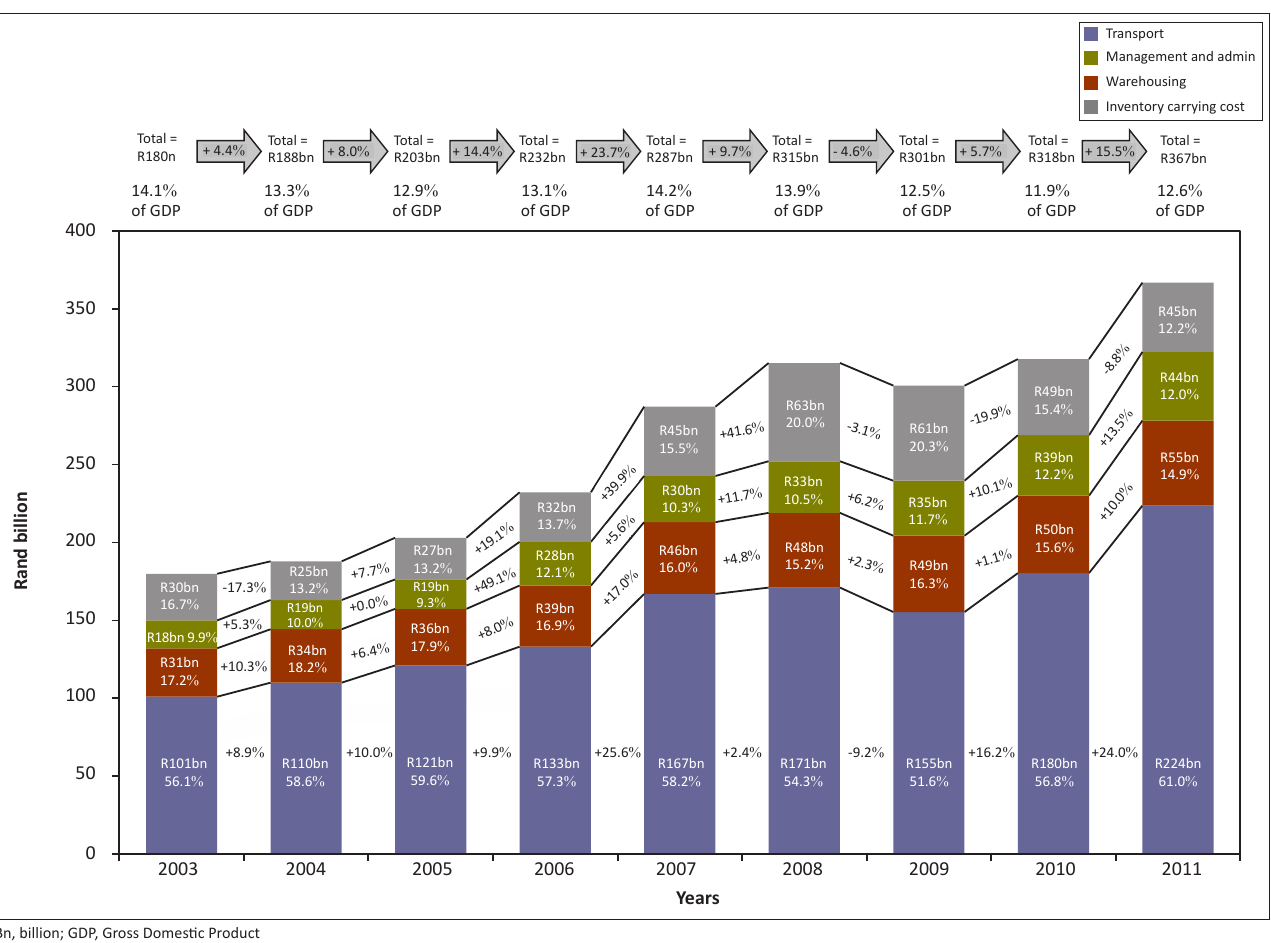
FIGURE 1: South Africa’s logistics costs components and Gross Domestic Product